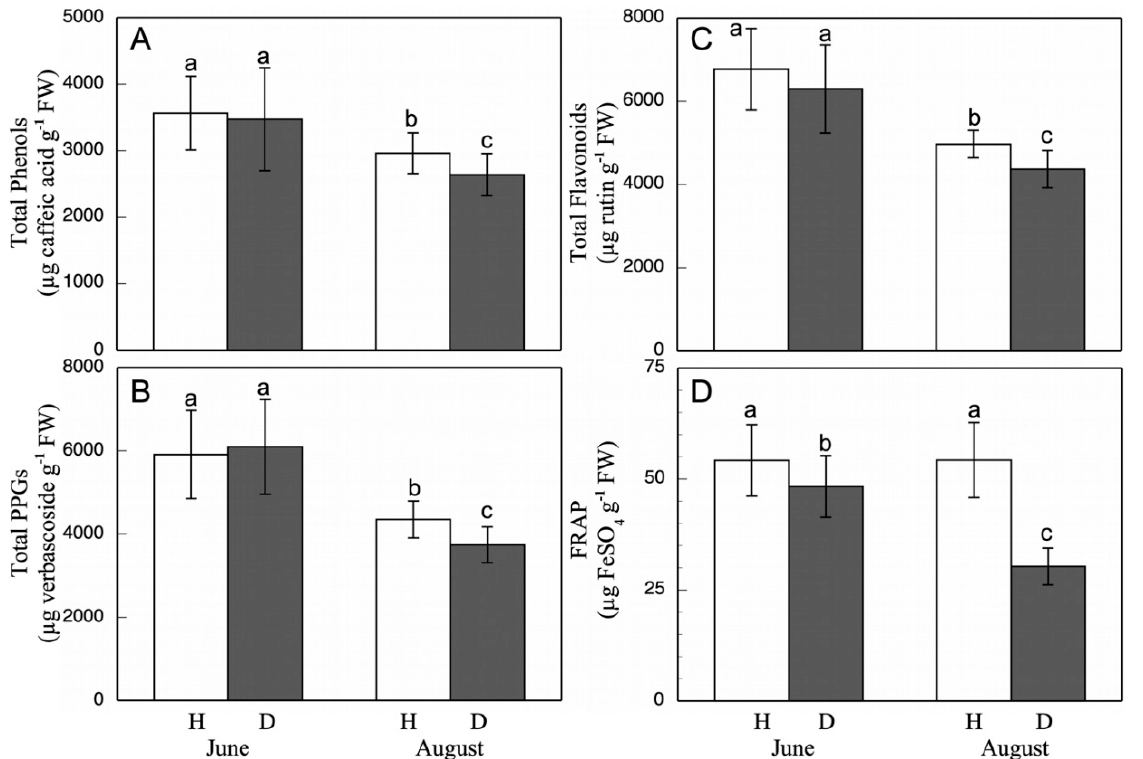
Figure 1. Total phenol ( A ), PPG ( B ), and flavonoid ( C ) contents, and FRAP ( D ) in grapevine healthy (H) and esca-diseased (D) leaves from June and August. The data are means ± SD from 10 independent experiments, each carried out in triplicate (different letters indicate significant differences at p < 0.05, Mann–Whitney U test).